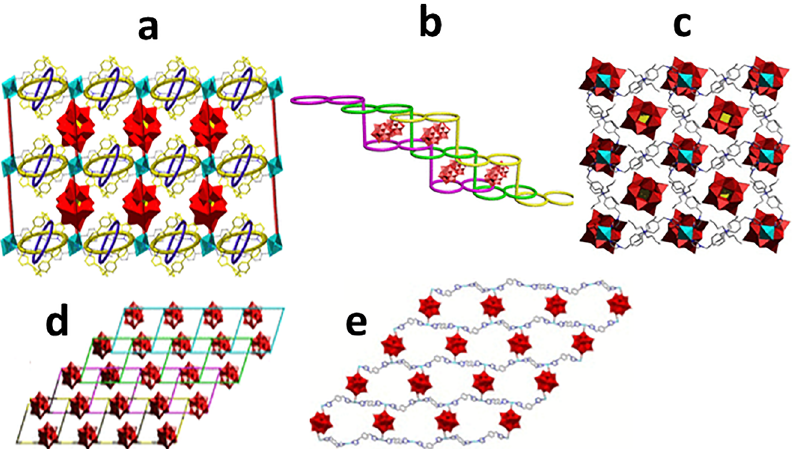
Figure 10: Structural difference of five different POMOFs synthesized ionothermally for photocatalytic H 2 evolution. (a) POMOF1 (b) POMOF2, (c) POMOF3, (d) POMOF4, (e) POMOF5. Adopted with permission from ref. [138].